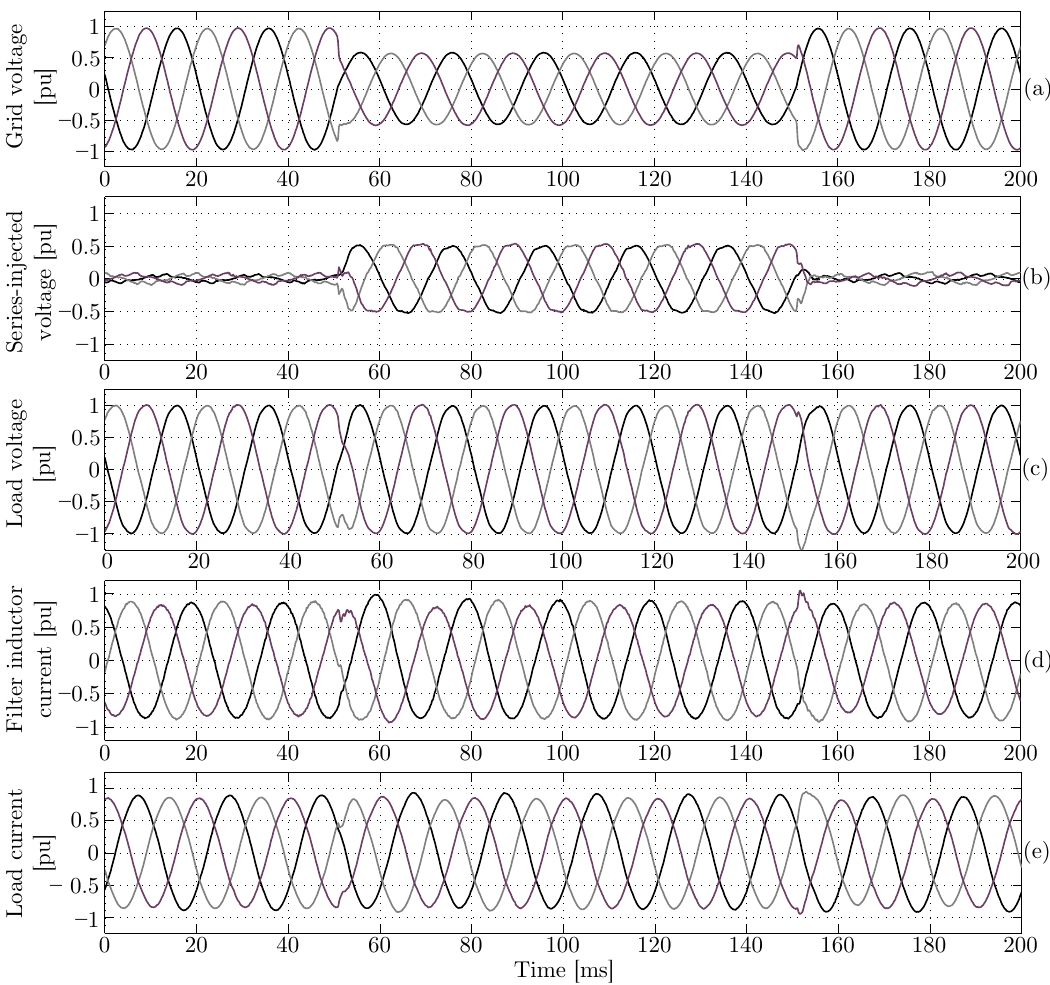
Figure 13. Experimental results. Mitigation of a sag (60% retained voltage) with the SF controller. ( a ) Grid voltage, ( b ) series-injected voltage, ( c ) load voltage, ( d ) filter inductor current, and ( e ) load